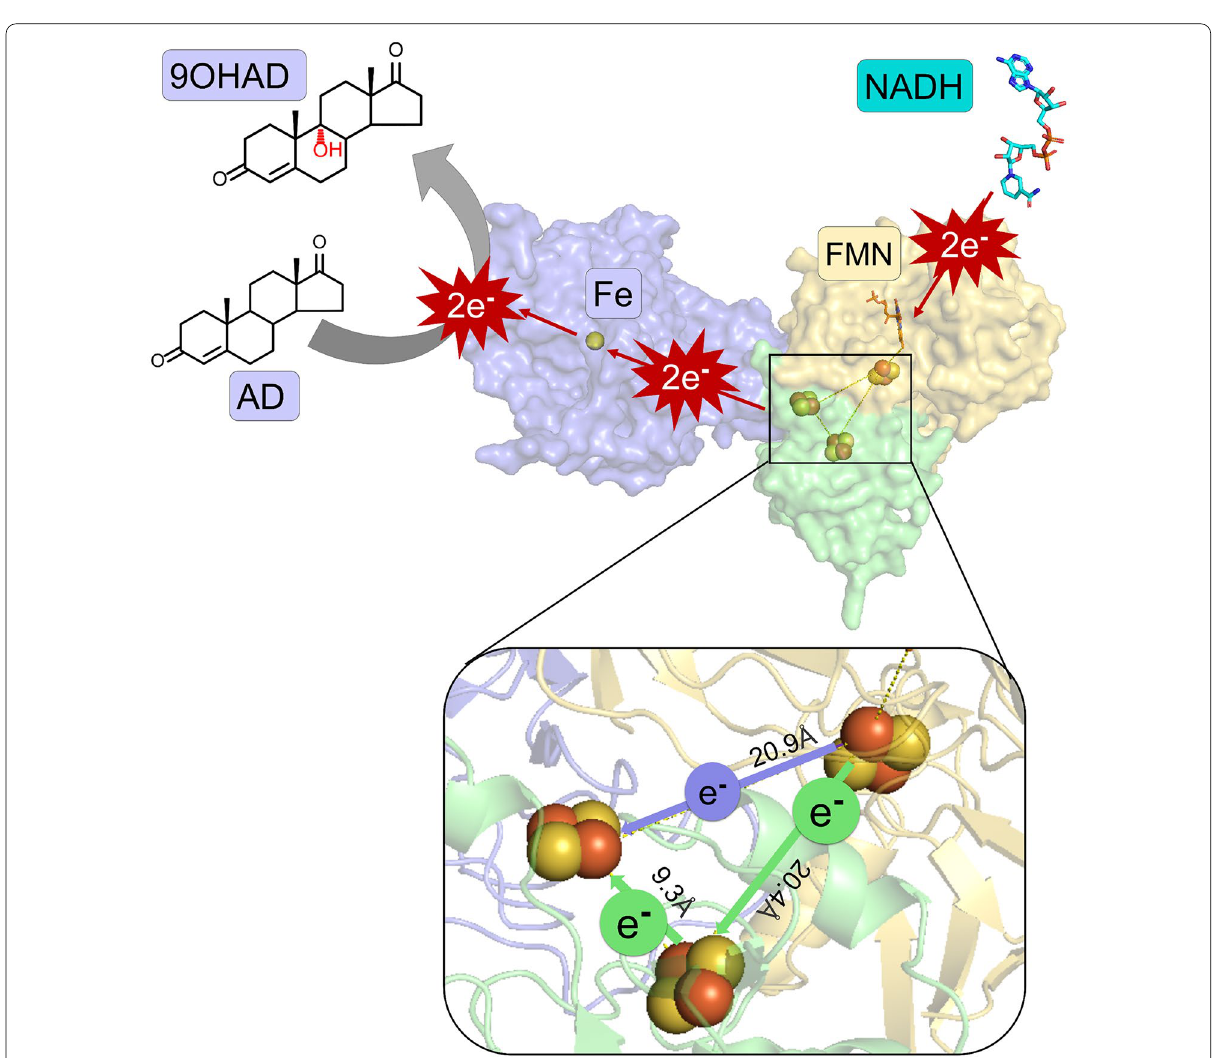
Fig. 5 Analysis of the proposed electron transfer pathway between oxidoreductase and free Fdx. The overall structures of reductase PRF, free ferredoxin DmFdx2 and oxygenase KshA are shown as surface representation. NADH and FMN are shown as sticks, iron atoms and [2Fe–2S] cluster groups are shown as